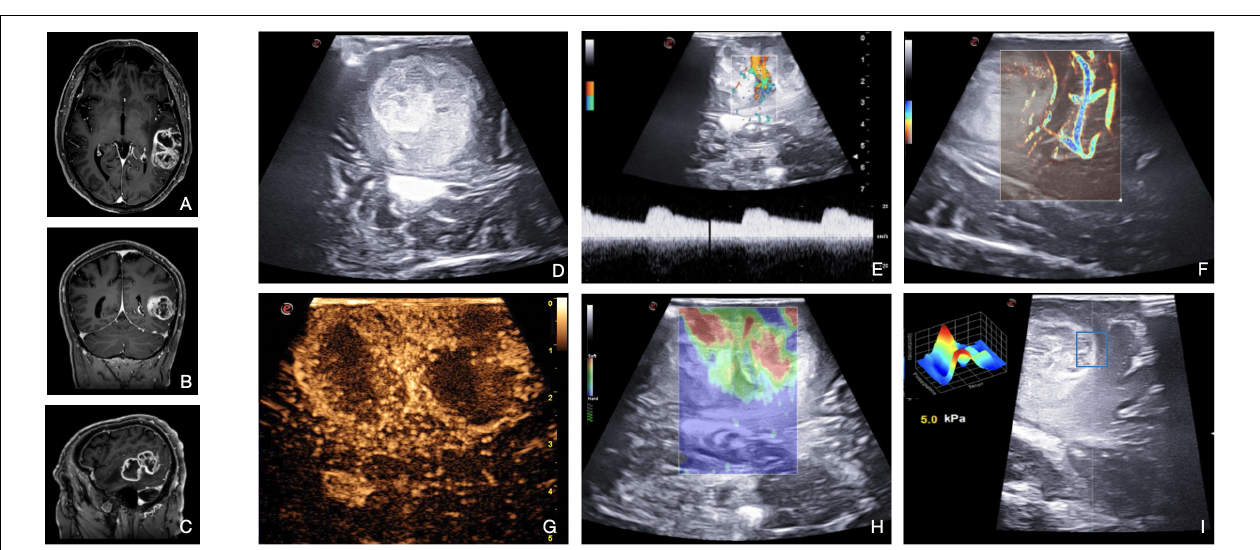
FIGURE 6 | Illustrative case of glioblastoma (Grade 4 WHO, 2021). (A–C) Pre-operative MRI demonstrates a left temporal high-grade, enhancing intra-axial tumor. (D) B-mode provides mainly structural information on the lesion and on the main relationships with surrounding structures. B-mode shows the presence of a vast hypoechoic necrotic core within the lesion. Color-Doppler (E) and MicroV (F) depict the main vessels and create a map of the vascular tree. Spectral-Doppler characterizes the flow inside a vessel, thus providing information on the nature and relevance: in panel (E) an artery between the two lesion’s necrotic core with a flow velocity of 20 cm/s. MicroV highlights the surrounding vessels and the smaller capillaries inside the lesion. CEUS (G) provides a representation of the anatomical and functional architecture of the entire vascular tree. The image acquired at the peak phase is suggestive for the entity of perfusion of HGG, also dissecting the components of the lesion: two intense CE ring-shaped areas of vital tissue delineating two central low CE necrotic cores. Qualitative (H) and quantitative (I) elastosonography inform on the stiffness of the different components of the lesion (e.g., necrosis vs. vital tissue) and on the interface between tumor and brain. SE shows two soft areas (red) surrounded by stiffer areas (green-blue). SWE, using the QElaxto algorithm, can define the stiffness of a specific ROI inside or outside the